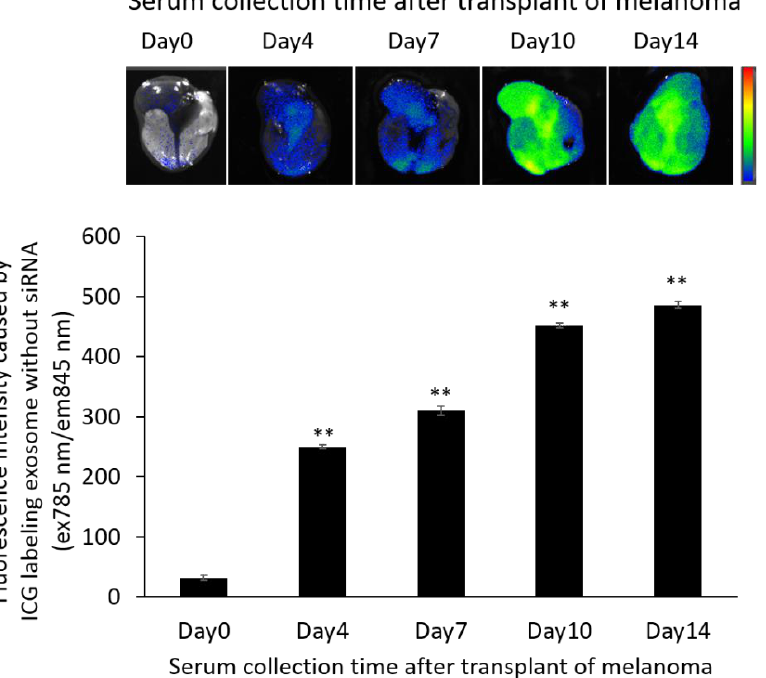
Figure 6. In vivo fluorescence imaging of the lung in B16/BL6 spontaneous lung metastasis model mice treated with ICG-labeled exosomes. Data were obtained 24 h after treatment with ICG-labeled exosomes. Data represent the mean ± SD of three independent experiments; ** p < 0.01 versus control B16/BL6 spontaneous lung metastasis model mice (Bonferroni test/ANOVA).